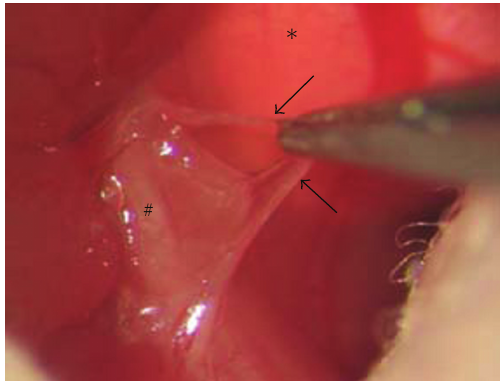
Figure 1: Surgical dissection of the vagus nerve using a microscope (40-fold magnification): the abdominal wall was opened through a transverse incision. Esophagus (#) and diaphragm ( ∗ ) were exposed and the ventral branch of the vagal nerve (arrows) was dissected. The dorsal branch of the vagus nerve was excised in the same